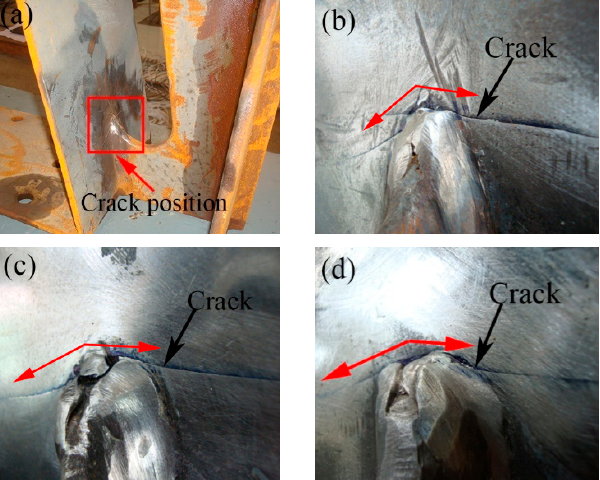
Figure 11. Cracks in the fatigue specimen: ( a ) Crack position in the specimen and Cracks of specimens ( b ) SY-3-1-2, ( c ) SY-3-1-5, ( d ) SY-3-1-6, respectively.